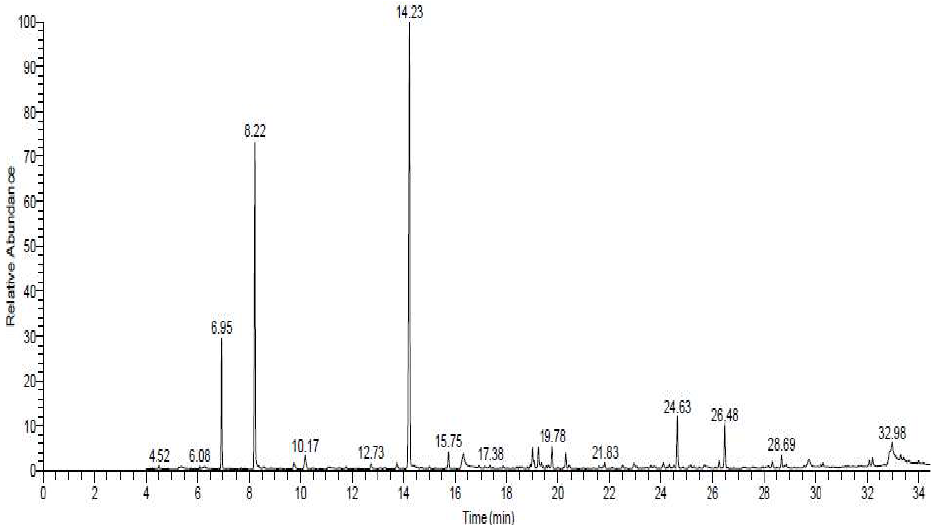
Table 1. Phytochemical contents of Allium sativum powder.